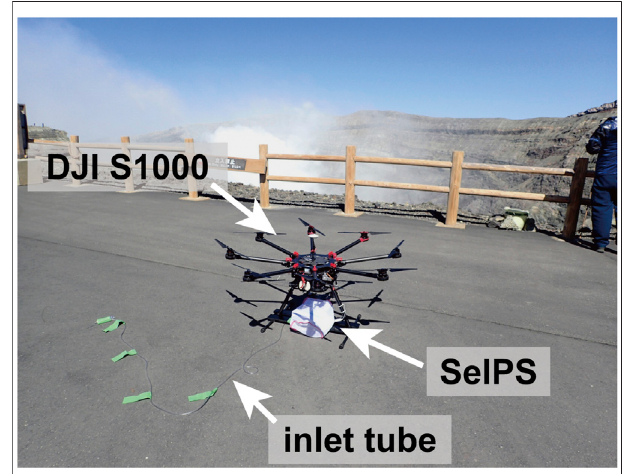
FIGURE 3 | A photo ofthe plume sampler SelPS fi xed on the DJI S1000 drone at Aso volcano. The sampler and aluminum bags are covered with a white plastic